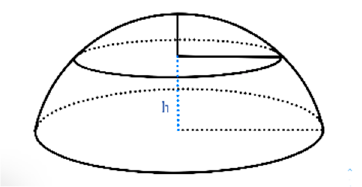
Figure 12. Schematic of the H-Dome.